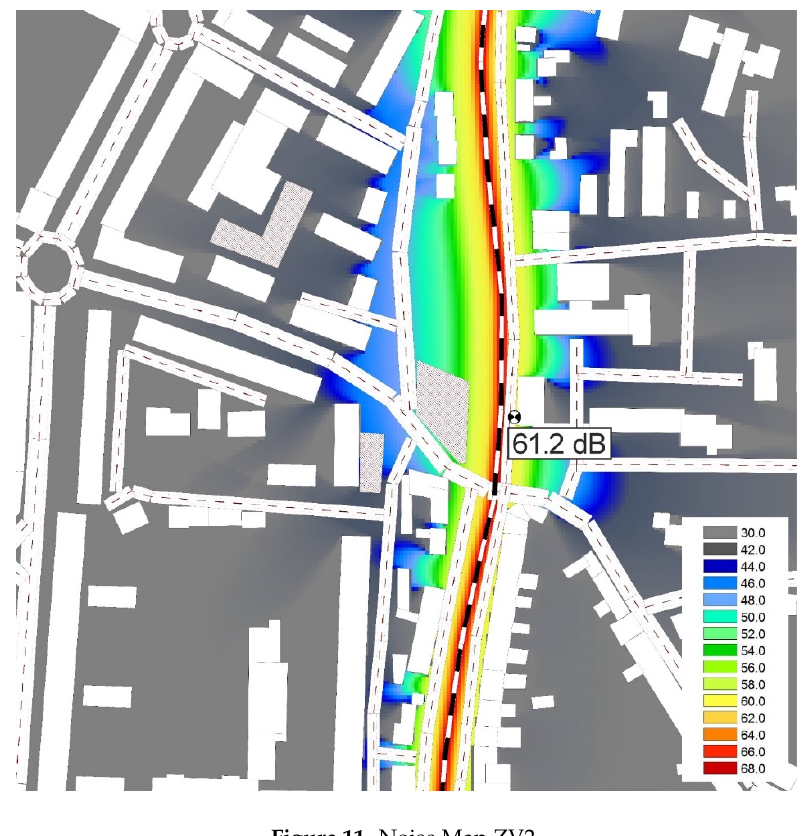
Figure 11. Noise Map ZV2.